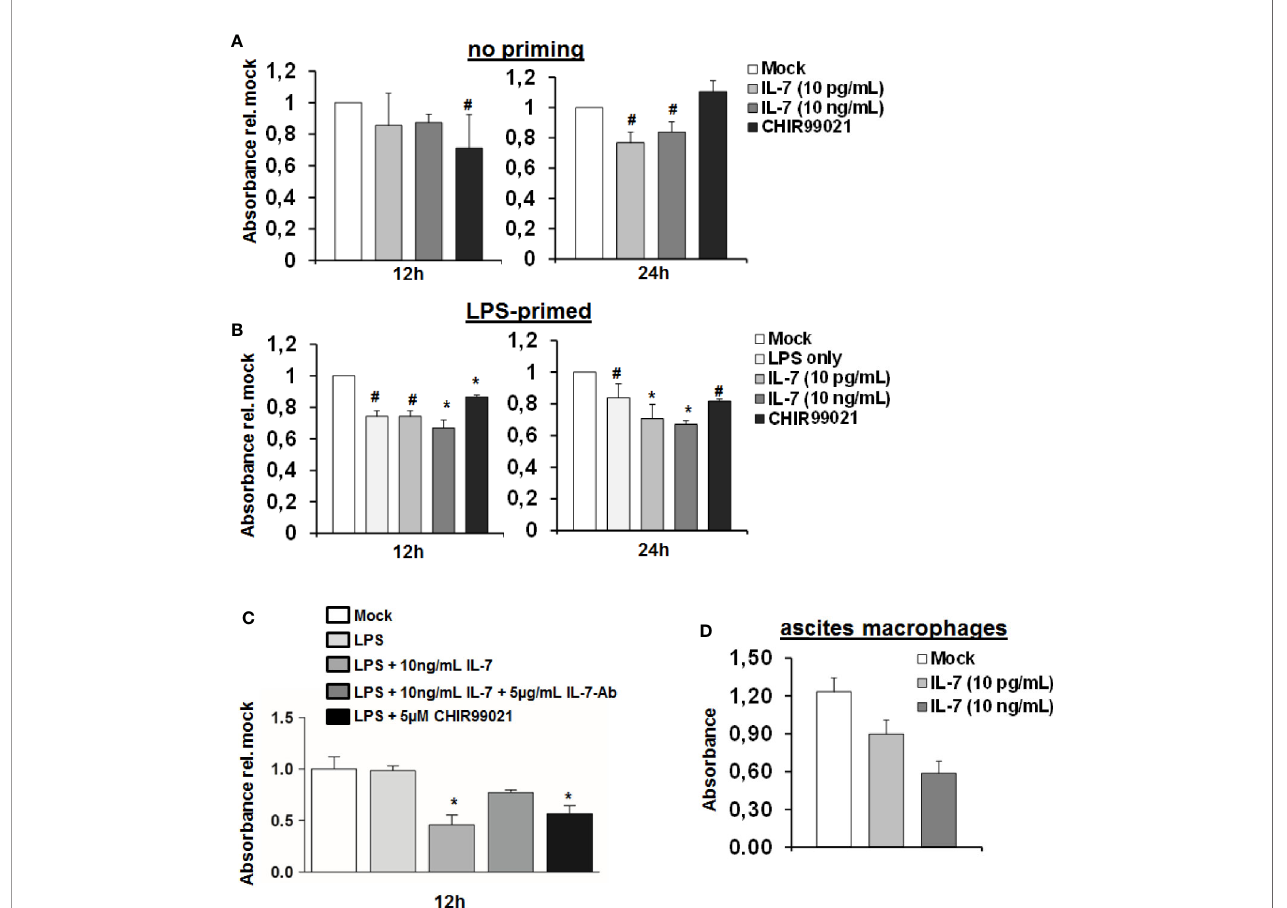
FIGURE 7 | Interleukin-7 (IL-7) decreases monocyte-derived macrophage viability. (A, B) Human monocyte-derived macrophages (MDMs) were pre-stimulated with (B) or without (A) 10 ng/ml lipopolysaccharide (LPS) for 16 h. Subsequently, cells were stimulated with the displayed concentrations of IL-7 or the Glycogen synthase kinase-3 (GSK3) inhibitor CHIR99021. Cellular viability was estimated using the WST-1 reagent at an absorbance of 450 nm relative to unstimulated cells. Standard deviations of three experiments (n=3) performed with three replicates each are shown. * P < 0.05 and # P < 0.1 for comparison of the indicated condition at the indicated time point versus mock. (C) MDMs were stimulated as in B) with or without addition of a neutralizing antibody against IL-7. * P < 0.05 for comparison of the indicated condition versus mock. Standard deviations of two experiments (n=2) performed with three replicates each are shown. (D) Macrophages were isolated from ascites fl uid of two liver cirrhosis patients (n=2, 3 replicates each) with spontaneous-bacterial peritonitis (SBP) and directly stimulated with IL-7 at the displayed doses. Cell viability using WST-1 reagent was analyzed after 24